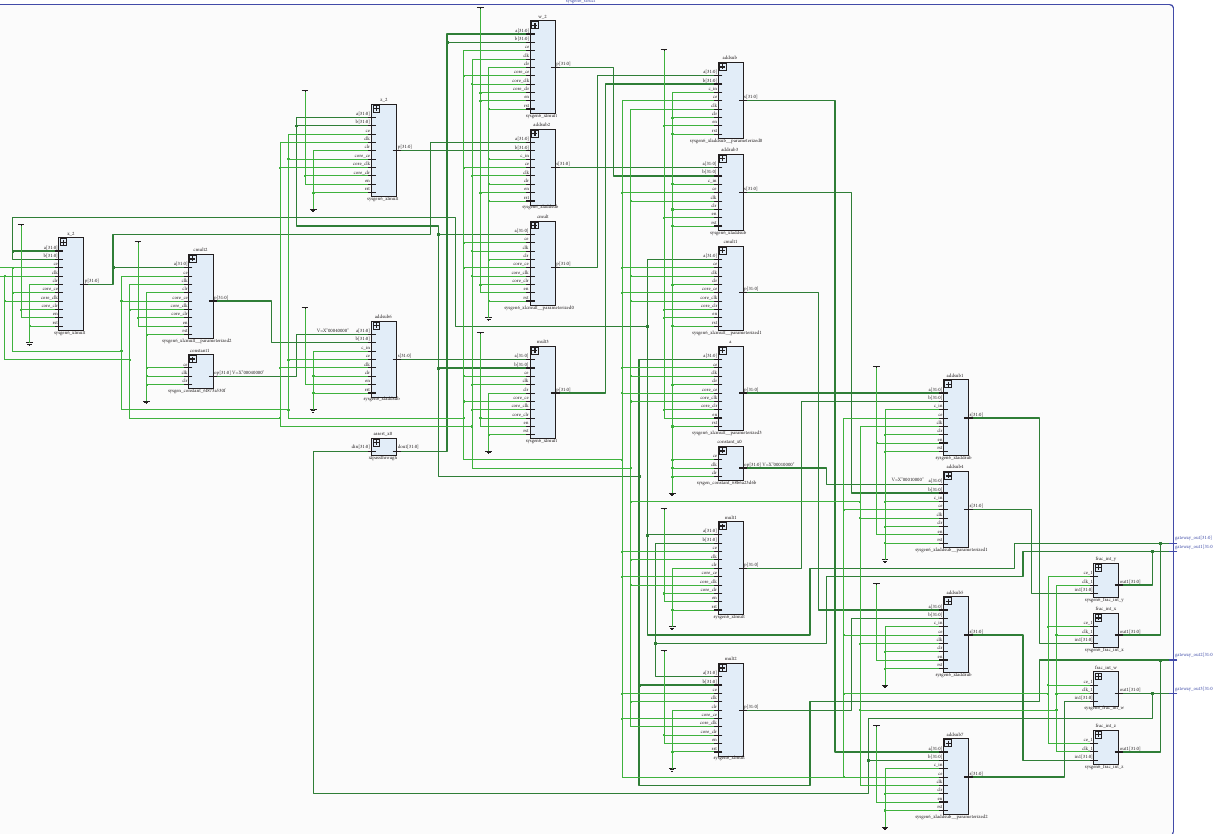
Figure 18: Xilinx schematics of the FOMNE system implemented in Kintex 7 (device = 7k160t; package = fbg484